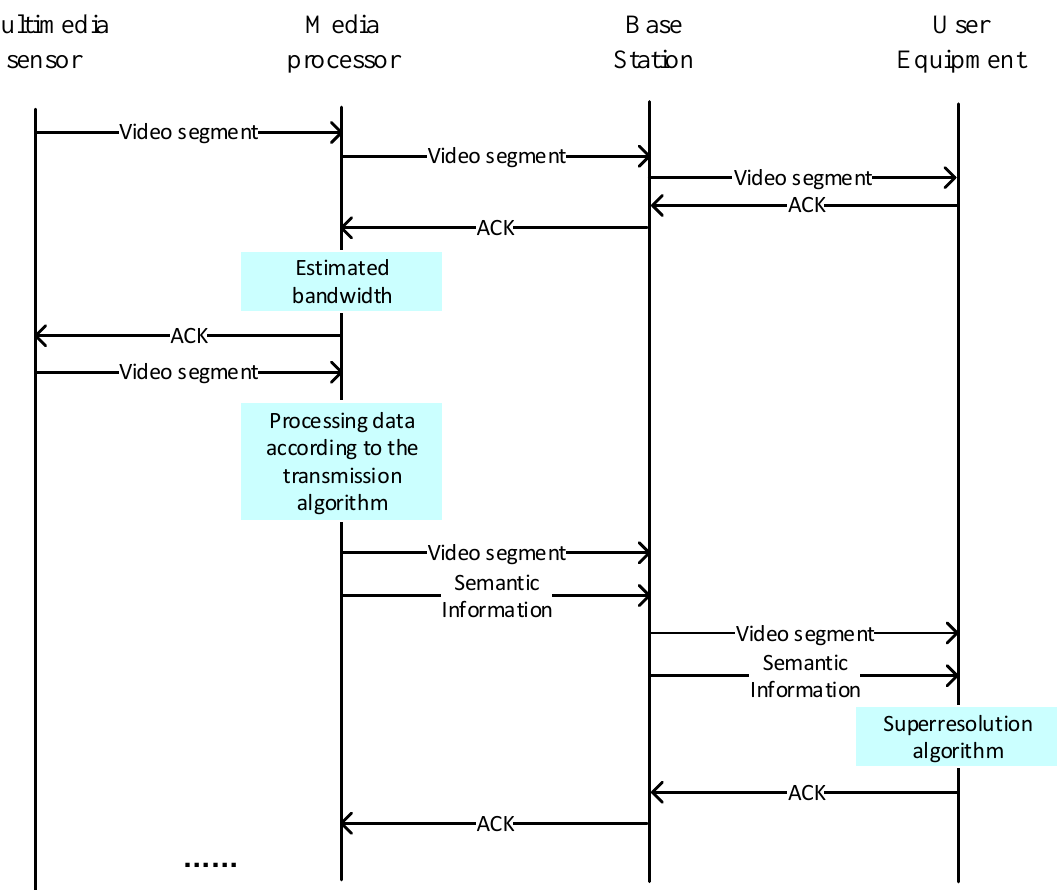
Figure 3. Process flow diagram of the proposed SASRT architecture for adaptive transmission over